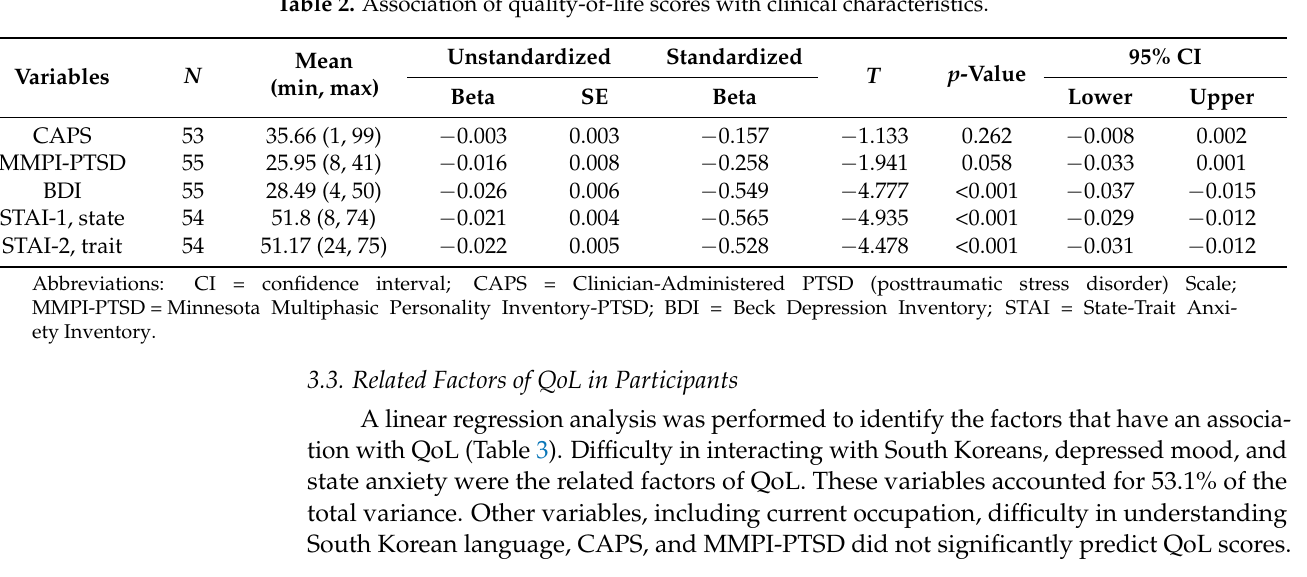
Table 2. Association of quality-of-life scores with clinical characteristics.